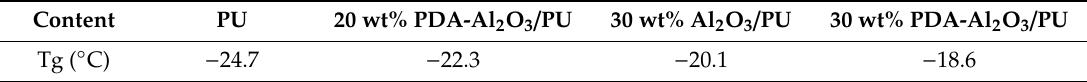
Table 1. Glass transition temperature of the composites.